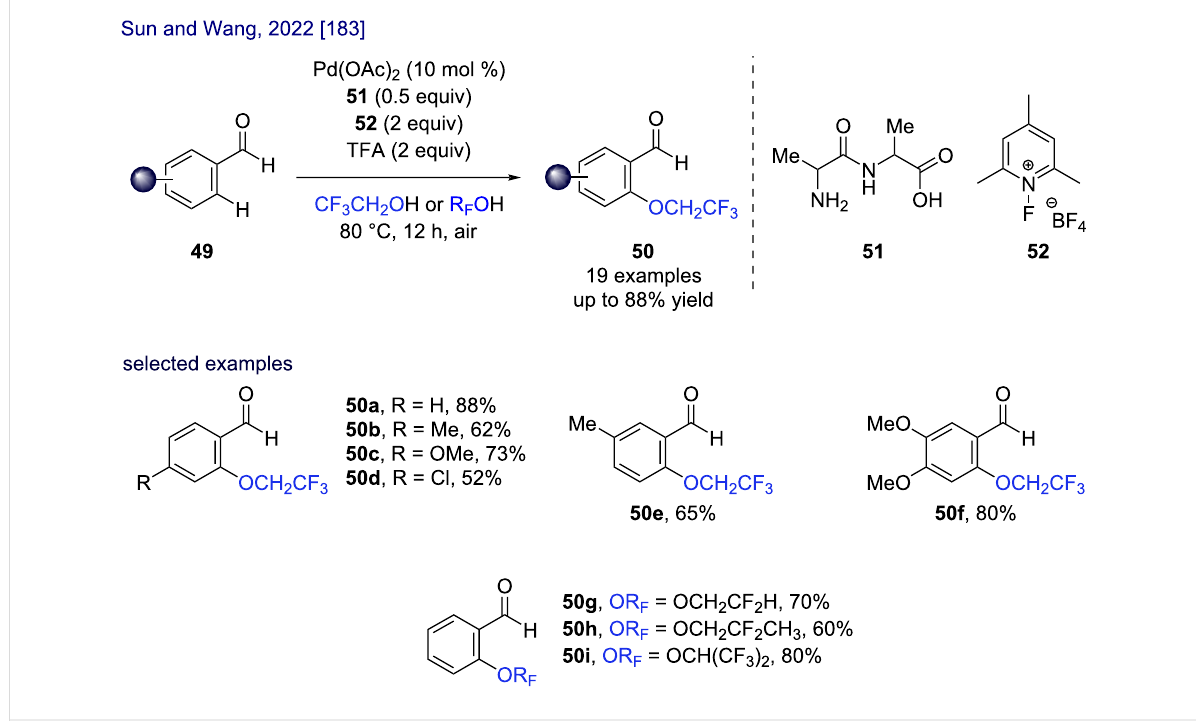
Scheme 23: Pd(II)-catalyzed selective ortho -2,2,2-trifluoroethoxylation (and other fluoroalkoxylations) of benzaldehyde derivatives via the assistance of a transient directing group reported by the group of Sun and Wang [183].